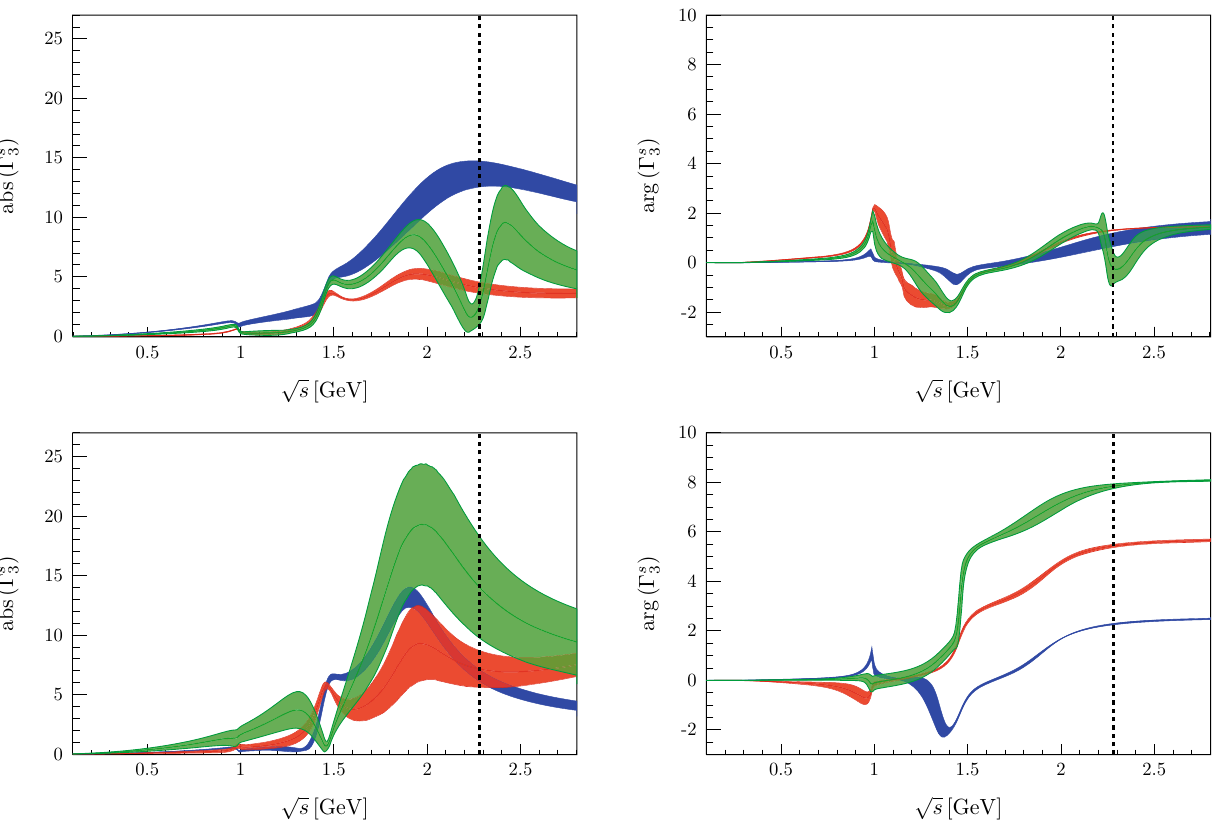
Fig. 8 Modulus (left, in arbitrary units) and phase (right) of the effective 4 π form factor Γ s channel. Fit 1 is shown in blue, Fit 2 in red, and Fit 3 in green. The dotted vertical lines mark the kinematic upper limit for